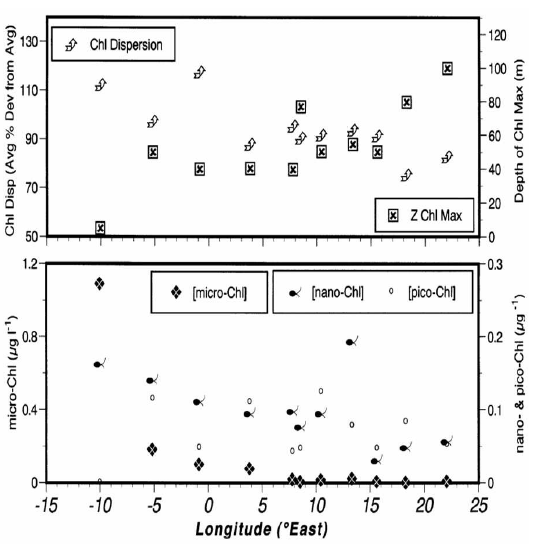
Fig. 7. The top panel shows the deepening of the DCM (Z Chl Max) and the chl a dispersion (Chl Dispersion) as an average of the discrete depth difference from water column average of chl a concentration, in percentage. Dispersion values in the WMS are closer to 100% than in the EMS, demonstrating a higher vertical patchiness in the latter. The bottom panel represents the west to east decrease for calculated chl a in pico-, nano- and microplankton. Note the Longitude scale: the two data points to the left are outside the MS, while the Levantine basin was not sampled. Modified with permission from Dolan et al. (2002).